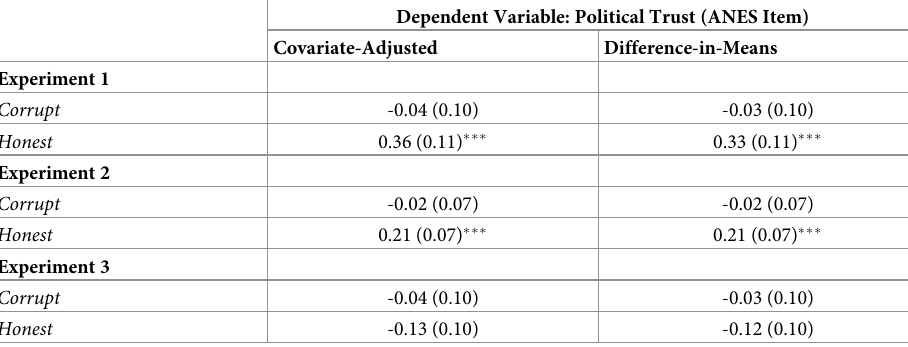
Table 1. Estimated treatment effects and standard errors in Experiments 1–3.